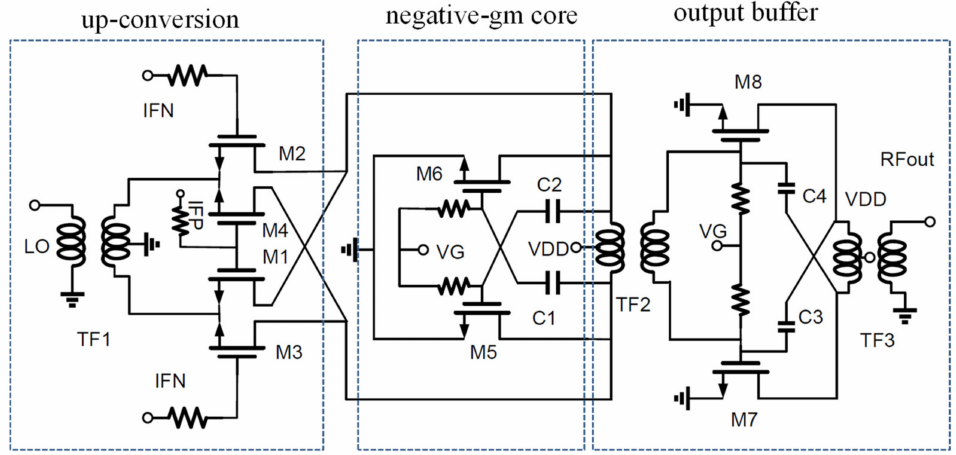
Figure 1. The proposed injection-locked binary phase-shift keying (BPSK)